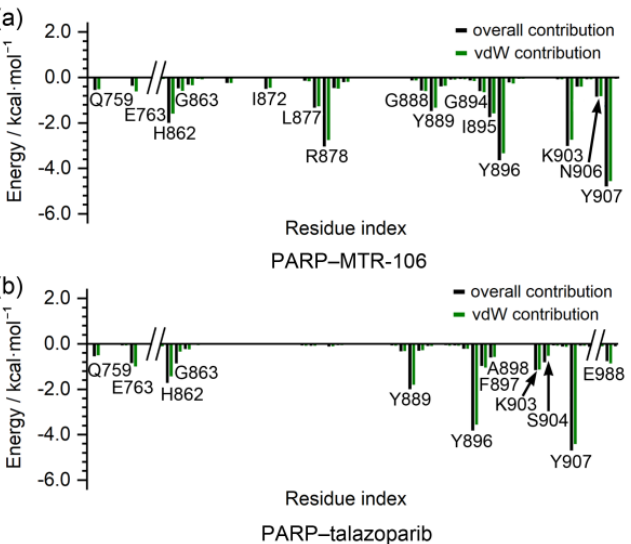
Figure 9. Per-residue decomposition of binding-free energy. The per-residue-based overall and vdW contributions are represented as black and green columns, respectively. Table 4. Binding-free energies between PARP1 and the binding ligands.